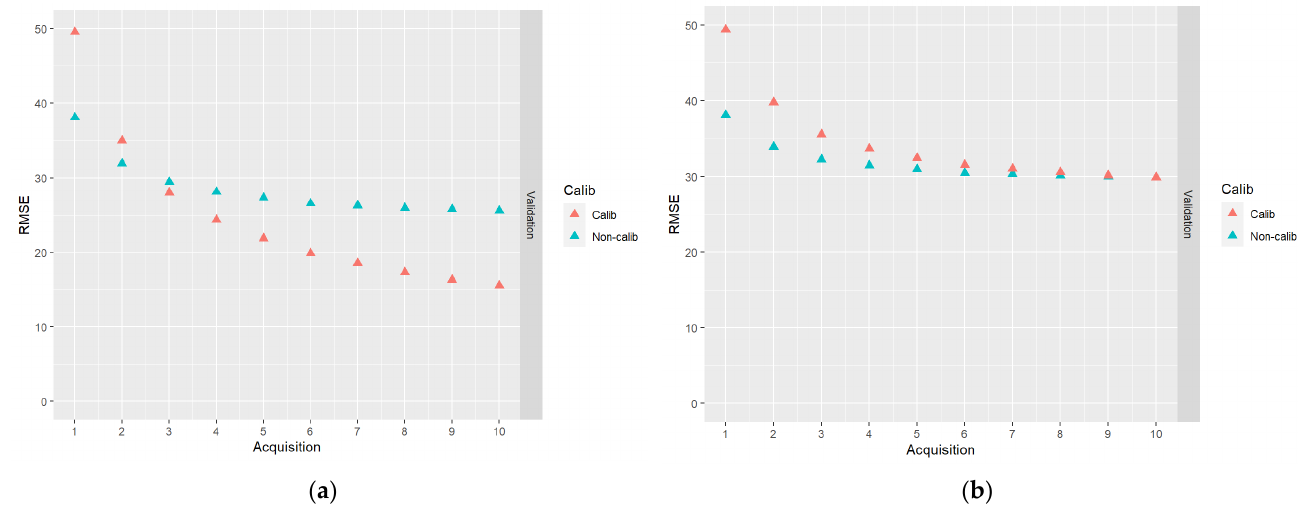
Figure 6. The results of DA schemes applying a sequence of 10 acquisitions of ALS data: ( a ) no correlations between model errors were simulated (case I); ( b ) correlations were simulated according to Table 2 (case II).